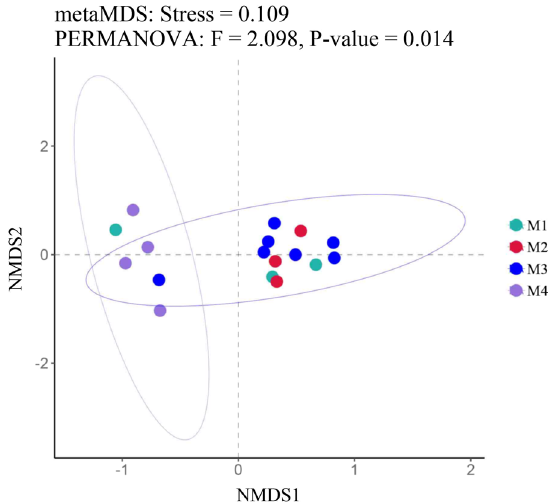
Fig. 3 Non-metric multidimensional scaling (NMDS) ordination for the community structure of freshwater mussels in Poyang Lake